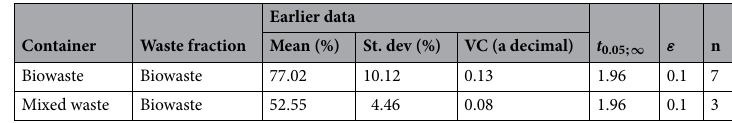
Table 2. Sample number